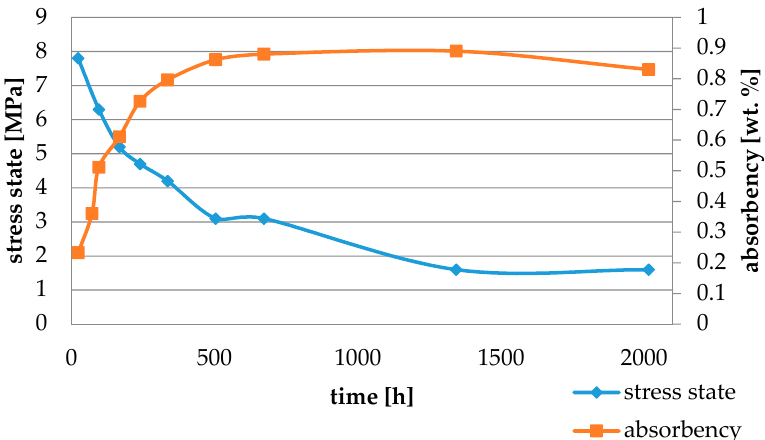
Figure 3. The influence of water sorption (2016 h water ageing) on the absorbency and contraction stress generated during the photopolymerization of NX3.